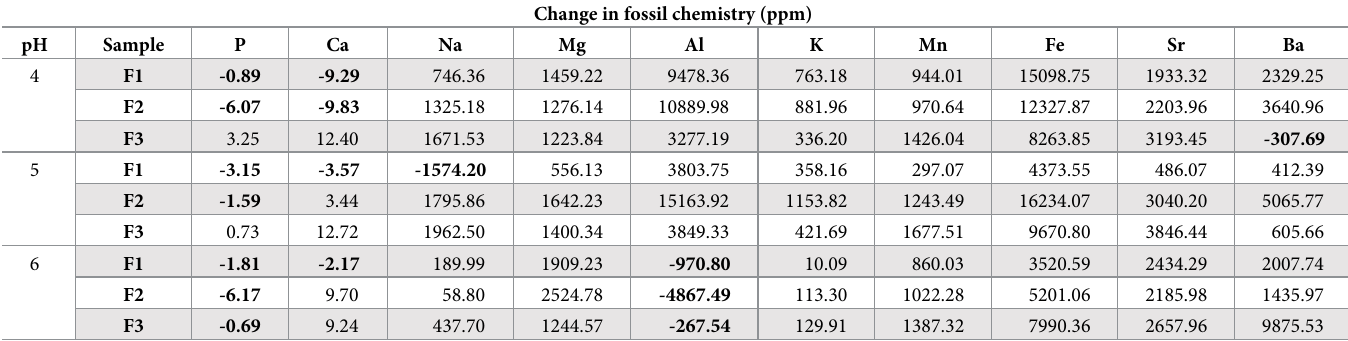
Table 4. Changes in fossil chemistry from pre- to post-dissolution